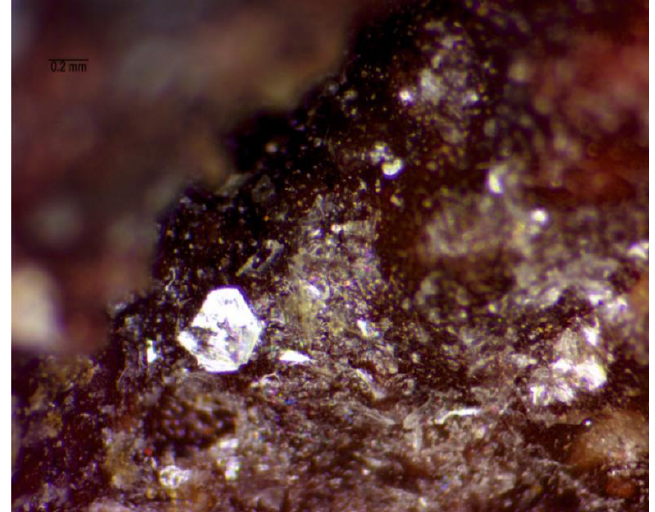
Figure 1. The colorless platelets of steklite on a sintered rock from the burnt dump of the Mine No. 47, Kopeisk, South Urals.